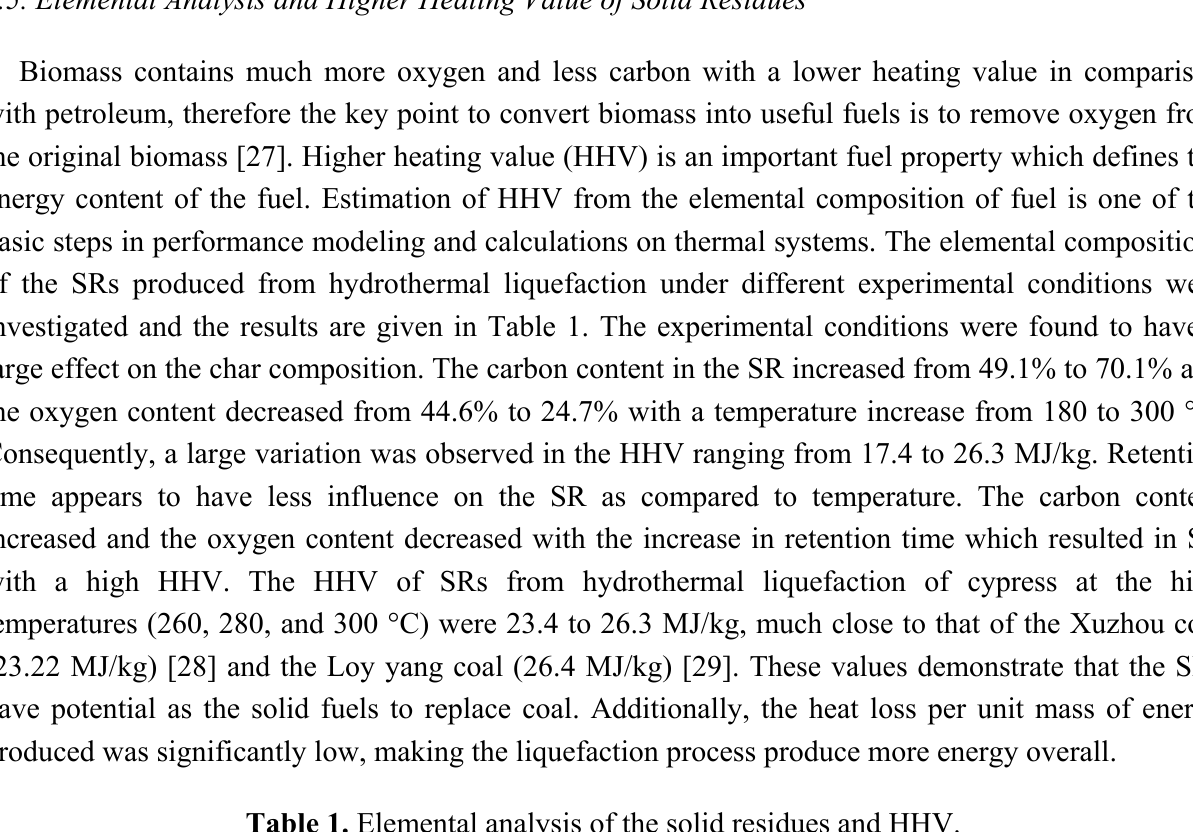
Table 1. Elemental analysis of the solid residues and